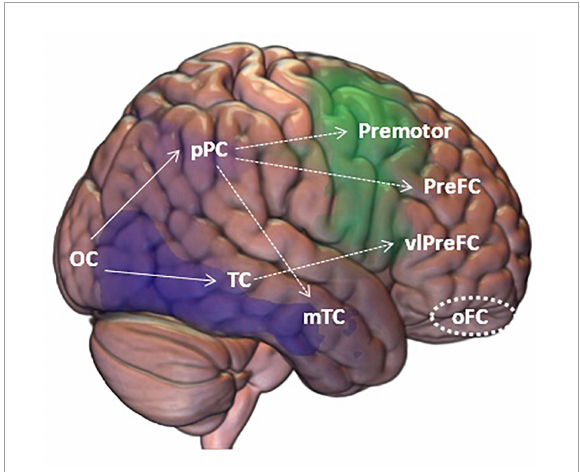
FIGURE6 Framework for visuospatial processing and the regions and mechanisms producing visuospatial tasks impairment according to our findings in bvFTD ( green ) and AD ( violet ). OC, Occipital Cortex; Ppc, posterior Parietal Cortex; TC, Temporal Cortex; Premotor, Premotor Cortex; preFC, pre Frontal Cortex; mTC, middle Temporal Cortex; vlPreFC, ventrolateral prefrontal Cortex; oFC, orbitofrontal Cortex. Solid lines show the classic “what” and “where” pathways; dotted lines show the expanded pathways; circle shows inhibition areas that were not related to the scores on the visual